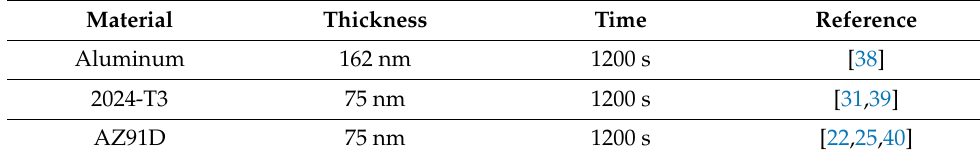
Table 1. Thickness of trivalent chromium conversion coating on different